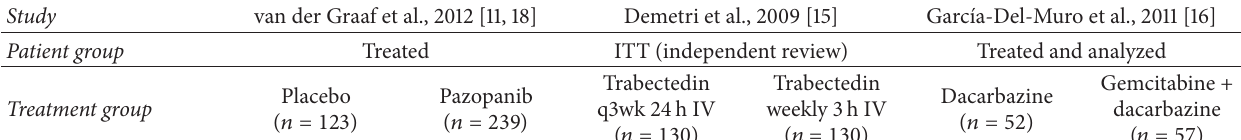
Table 5: Patients experiencing selected hematologic